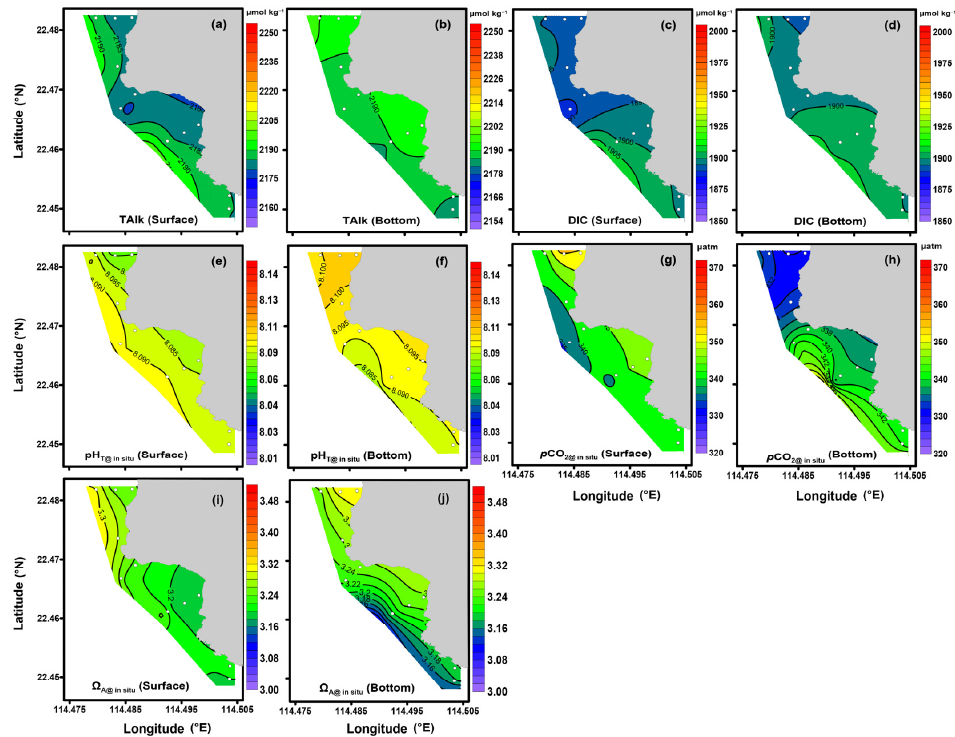
Figure 3. Distribution characteristics of TAlk ( a , b ), DIC ( c , d ), pH T@ in situ ( e , f ), p CO 2@ in situ ( g , h ) and Ω